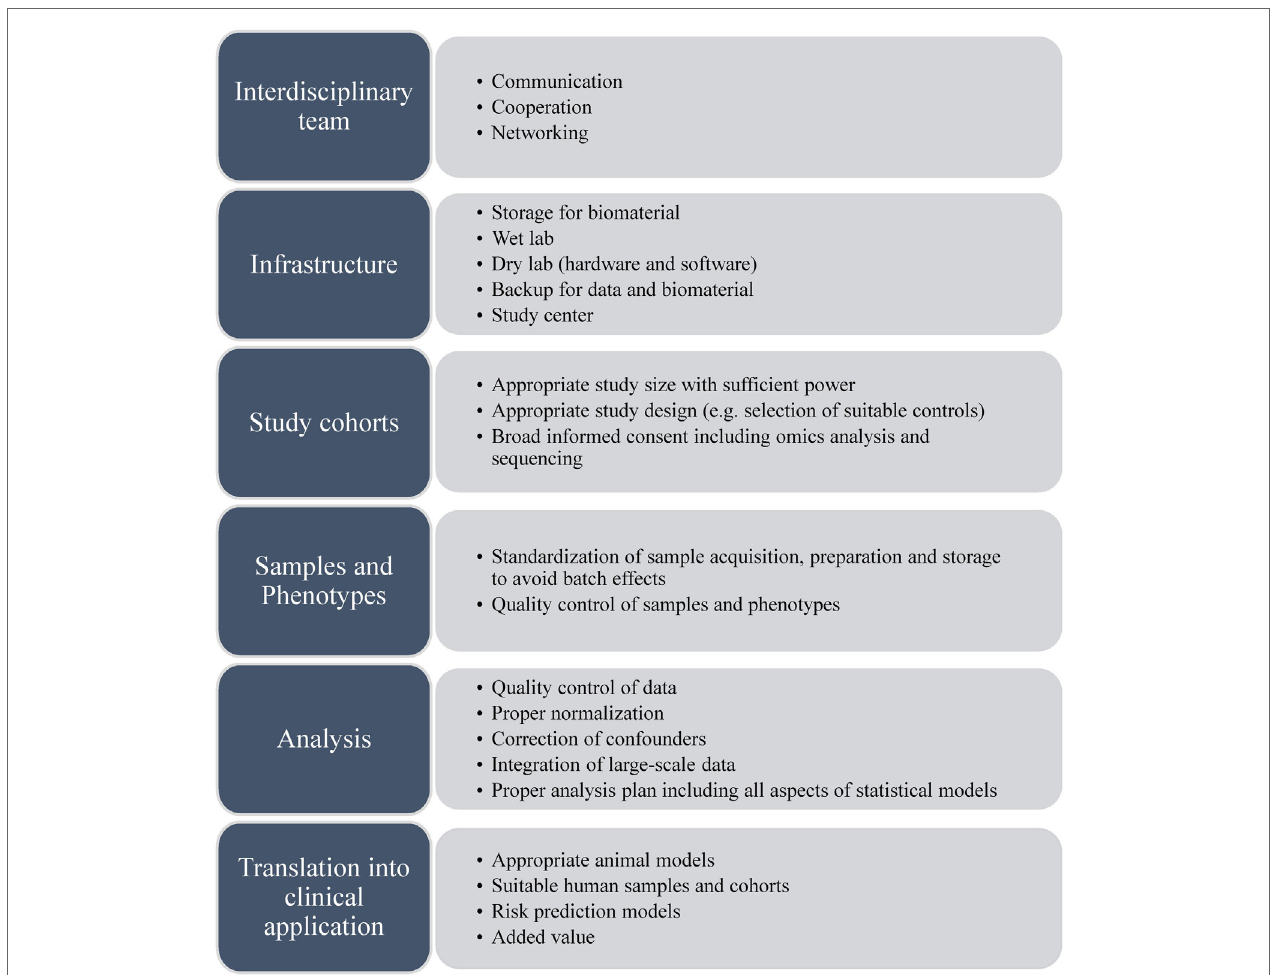
FiGURe 2 | Challenges for systems medicine approaches